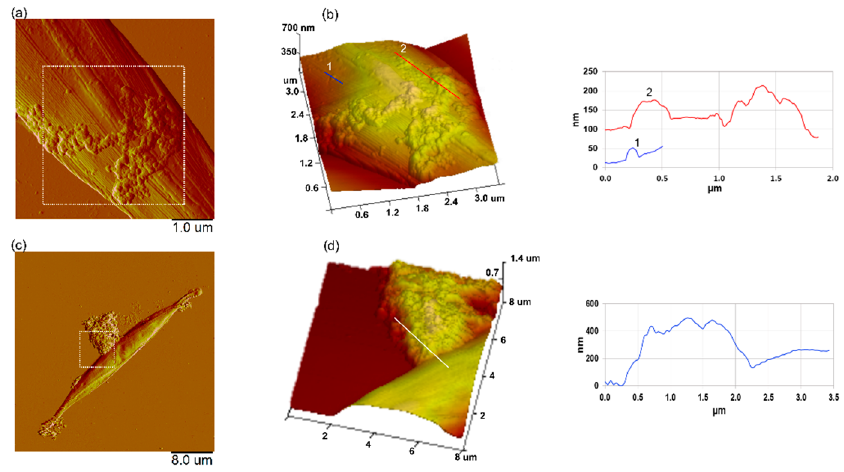
14 of 23 Figure 8. AFM images of Cylindrotheca closterium cell from control culture. AFM images of the whole C. closterium cell ( a ) and its morphological details ( b – d ). Vertical profiles along indicated lines in ( d ) along girdle band (red line, number 1) and valve (blue line, number 2) are shown next to image. Images are acquired using contact mode in air with scan sizes: 40 µm × 40 µm ( a ), 15 µm × 15 µm ( b ), 3 µm × 3 µm ( c , d ) and presented as deflection ( a – c ) and height data ( d ). Letters V, G, and R indicate the following features: valve, girdle band, and raphe opening, respectively. Representative AFM images of the C. closterium cells exposed to PS-NH 2 NPs (5 µg mL − 1 ) and PS-COOH NPs (200 µg mL − 1 ) are shown in Figure 9. C. closterium cells grown in a medium containing PS-NH 2 or PS-COOH NPs did not show any morphological changes in terms of the surface nanostructure or cell size, compared to control. However, PS-NH 2 nanoparticles were adsorbed onto the C. closterium cell, either as single particles